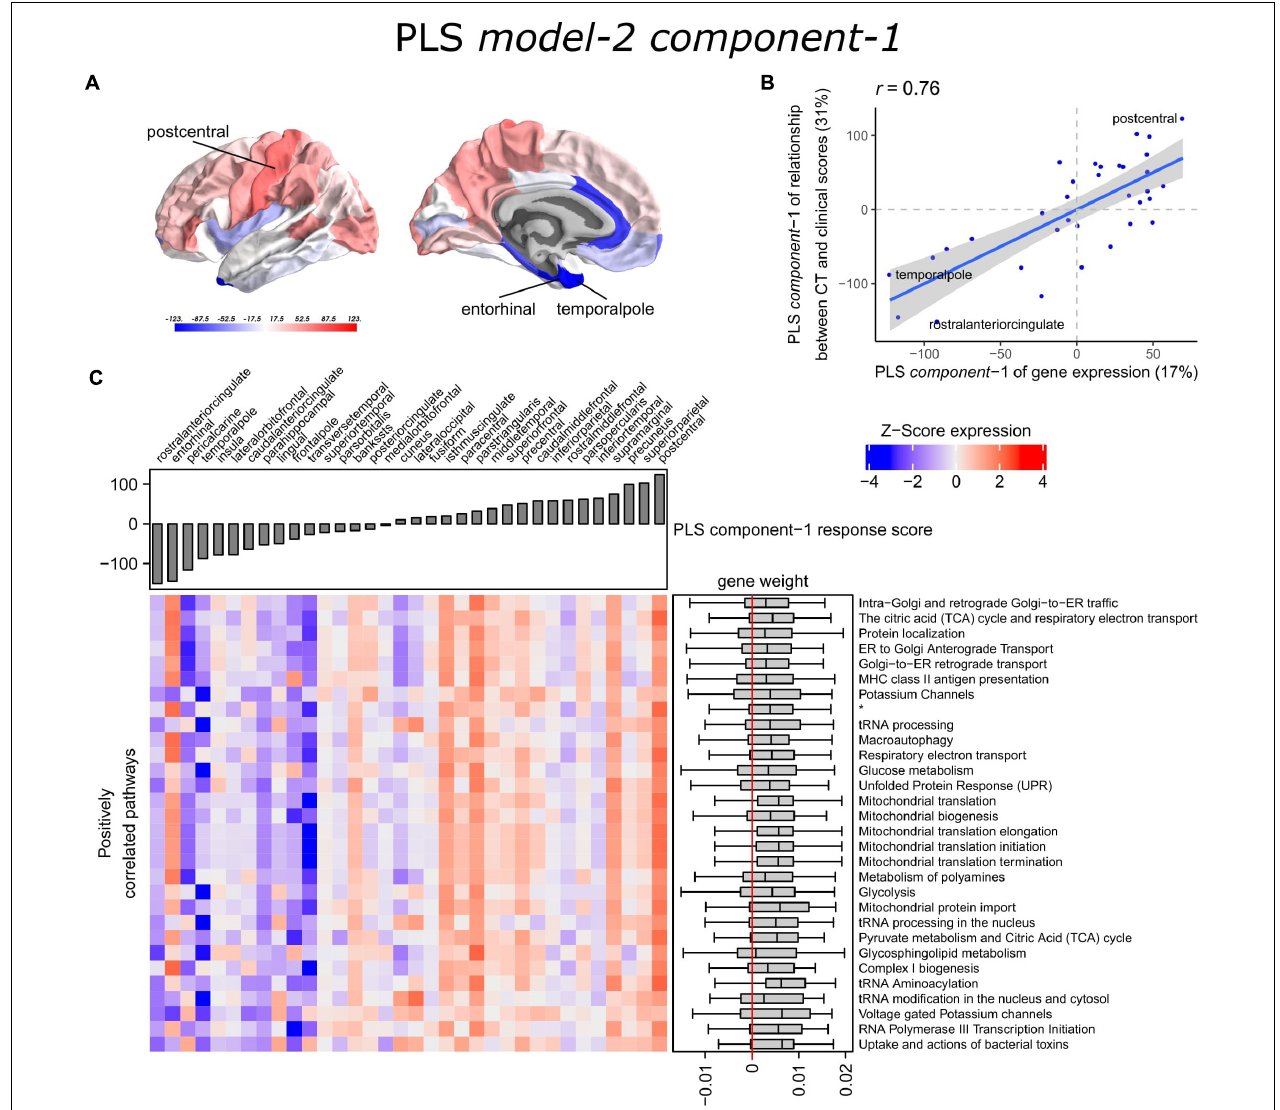
FIGURE 5 | Transcriptional signatures of PLS component-1 in PLS model- 2 predictive of the relationship between cortical thickness (CT) and clinical scores. (A) PLS scores for PLS component-1 of the predictor variables (gene expression) and (B) its correlation with PLS component-1 of the response variables ( t -statistic of β 1 in Eq. 1). Axes show the percentage of explained variance for each component; r indicates the Pearson correlation. (C) Mean expression across cortical regions (columns) of genes in the top 30 significant pathways (rows). A complete heatmap with all significant pathways is given in Supplementary Figure 8 . * = Respiratory electron transport, ATP synthesis by chemiosmotic coupling, and heat production by uncoupling